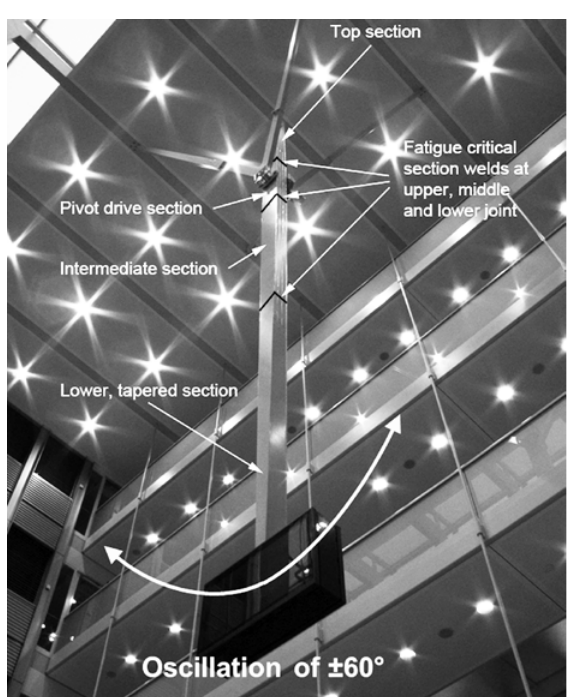
Figure 9. Artwork